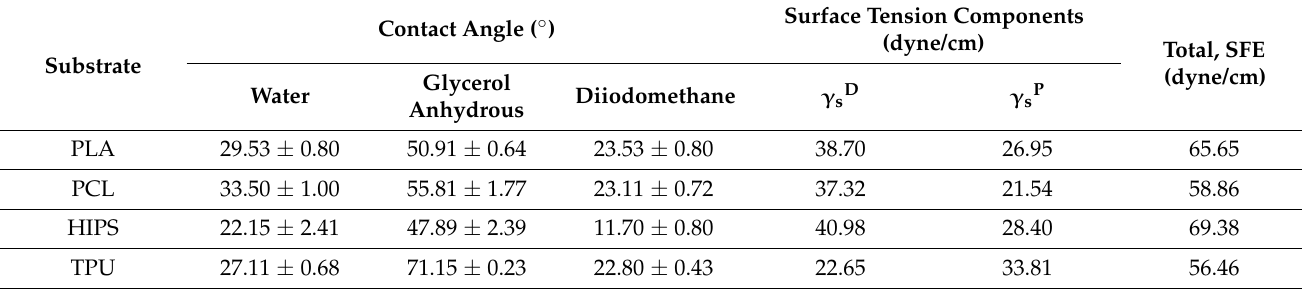
Table 2. Contact angle of the substrates and total surface free energy (SFE) values.